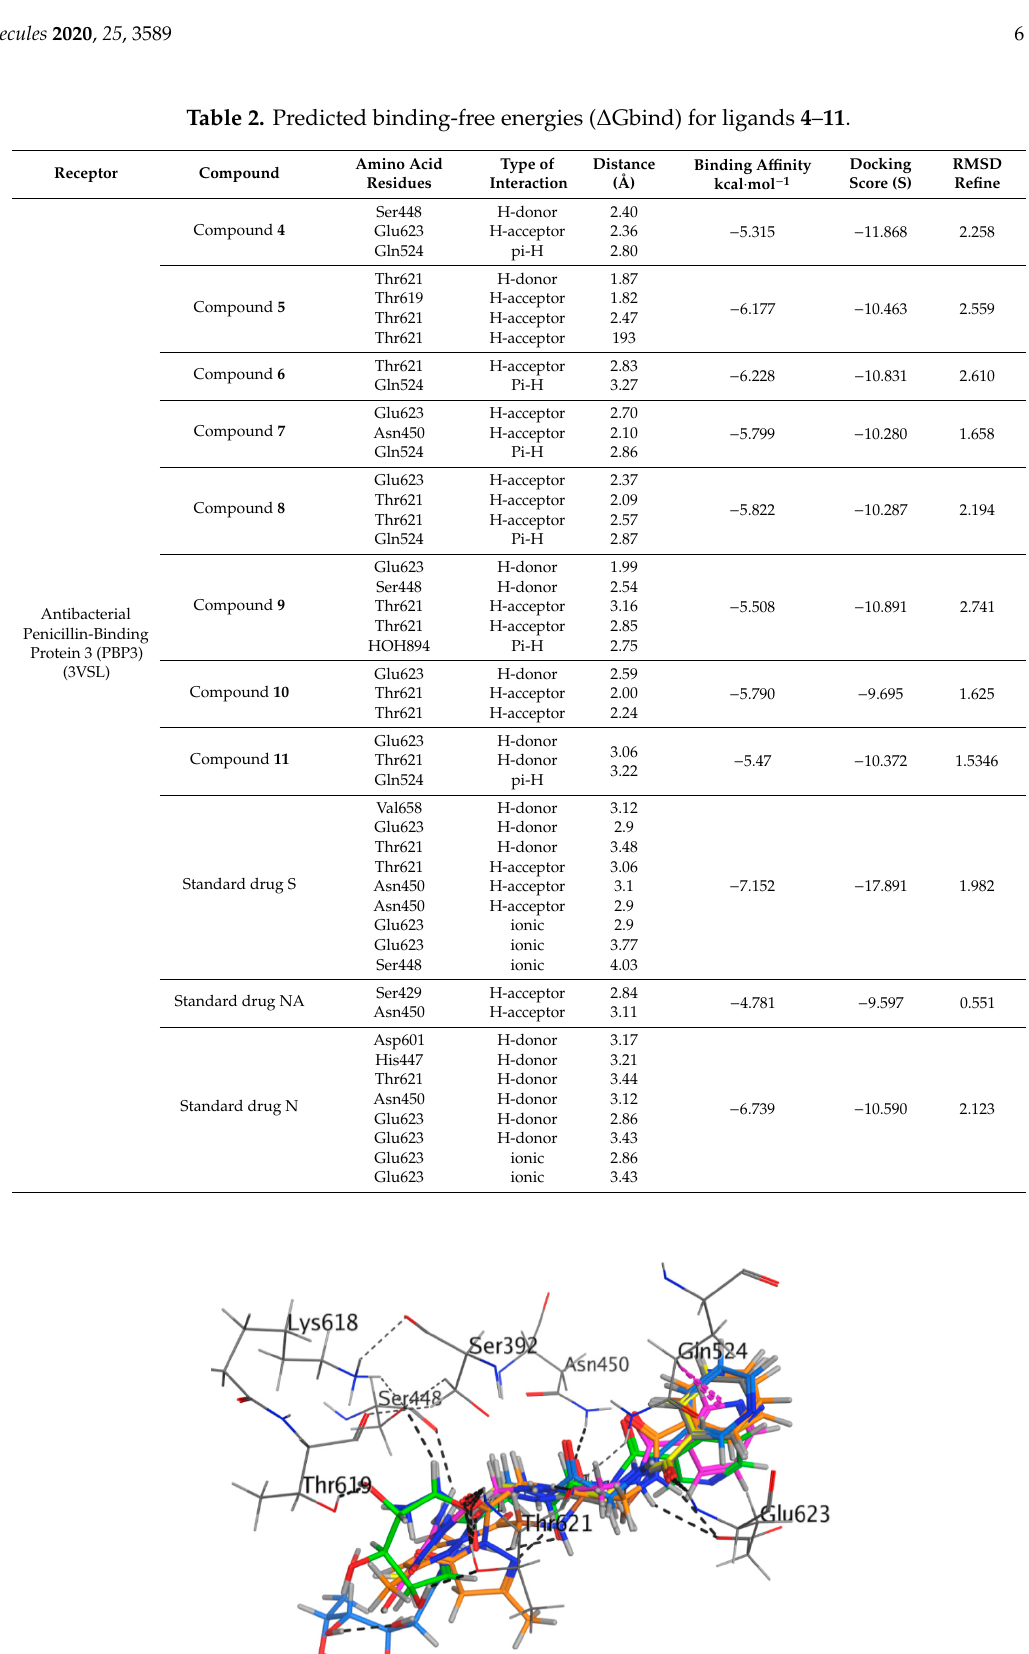
Figure 2. Compounds 4 to 11 superimposed by their poses of non-covalent docking in the active site of CYP51 pocket.